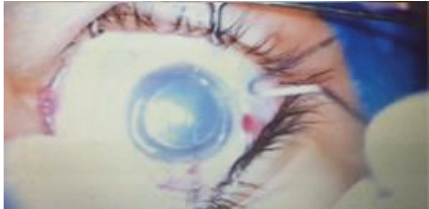
Figure 13: Air entrapment in the interface or “ Double Bubble.